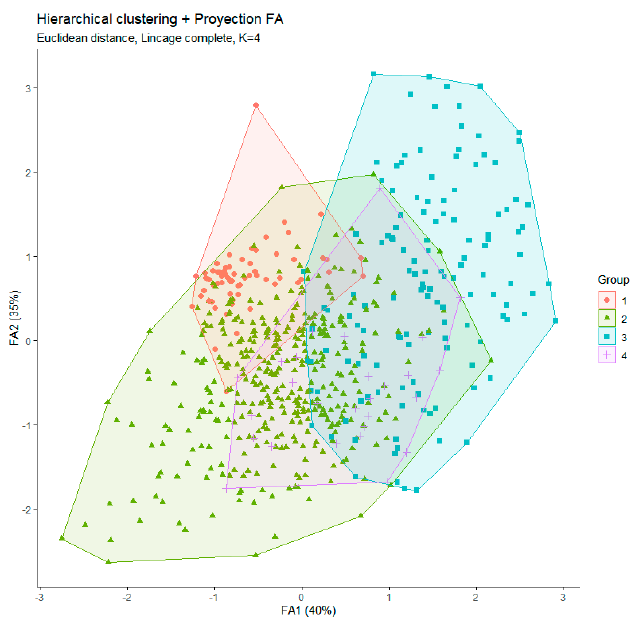
Figure 3. Hierarchical clustering and group of consumers projected in the FA1 and FA2 axes.